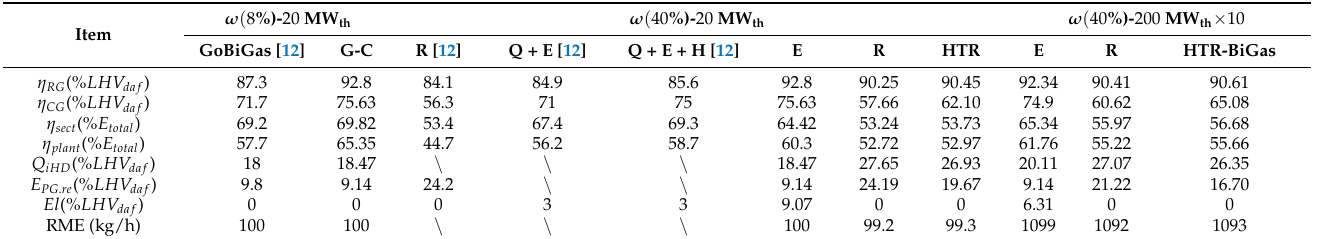
Table 6. Results of energy balances of GoBiGas, HTR-BiGas and related